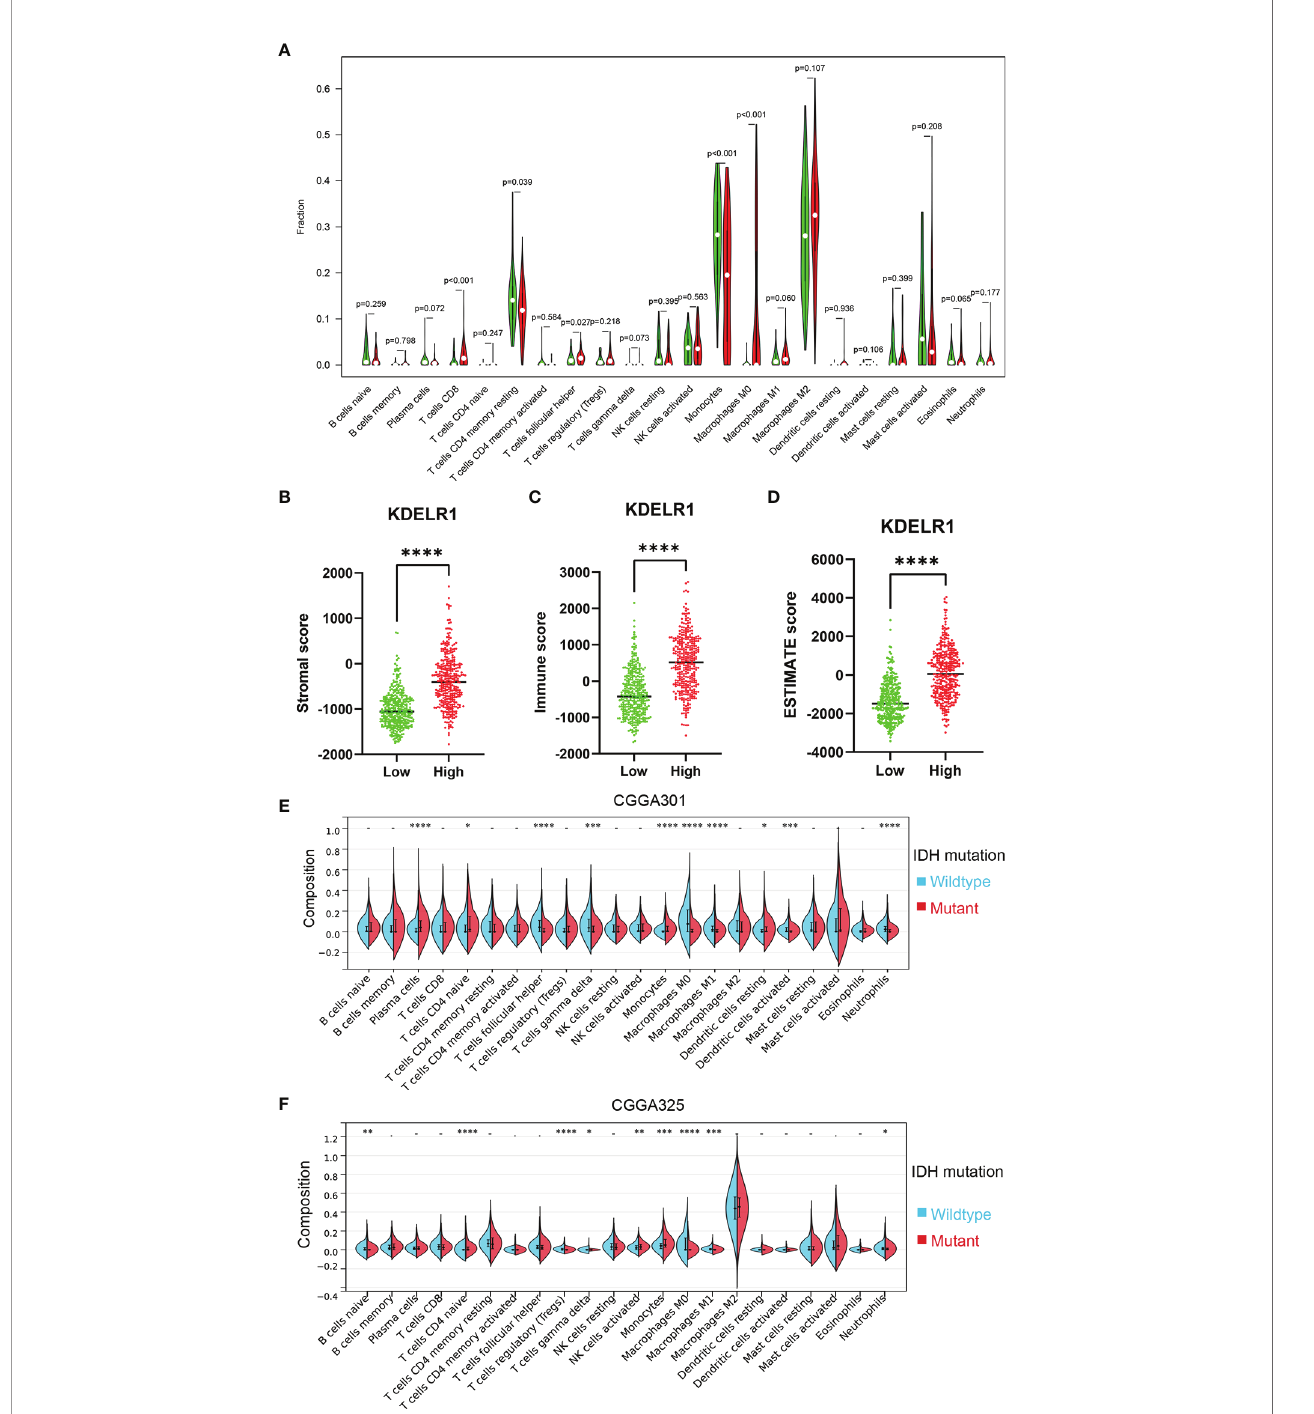
FIGURE 9 | Relationship between the ESTIMATE score and the KDELR1 expression level and proportions of the immune cells in KDELR1 groups in TCGA. (A) Proportions of the 22 types of tumor-in fi ltrate immune cells in two KDELR1 groups in TCGA. The high-KDELR1-expression group has a higher (B) stromal score, (C) immune score, and (D) ESTIMATE score than the low group in TCGA. The red represents the high-KDELR1-expression group, and the green indicates the low group. ****p < 0.0001. Violin plot showed the ratio differentiation of 22 kinds of immune cells between IDH mutation and wildtype glioma samples using the CIBERSORT algorithm in (E) CGGA301 and (F) CGGA325 cohorts. *p < 0.1, **p < 0.01, ***p <